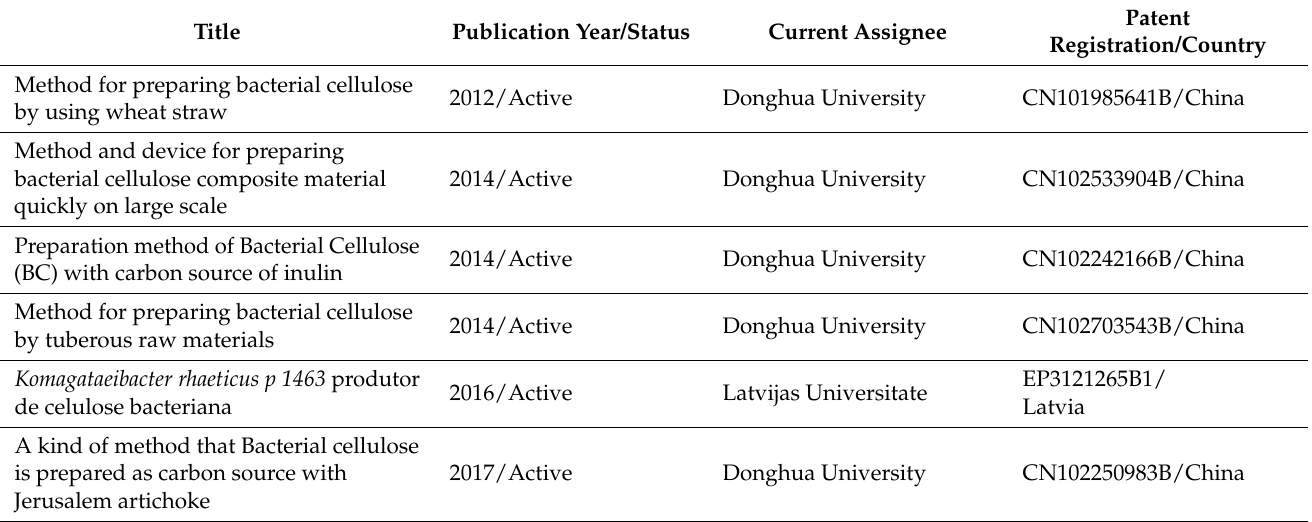
Table 3. Patents for bacterial cellulose production using